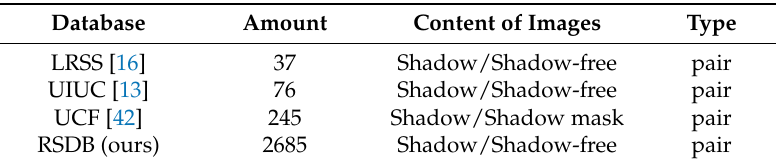
Table 1. Comparison table with other shadow